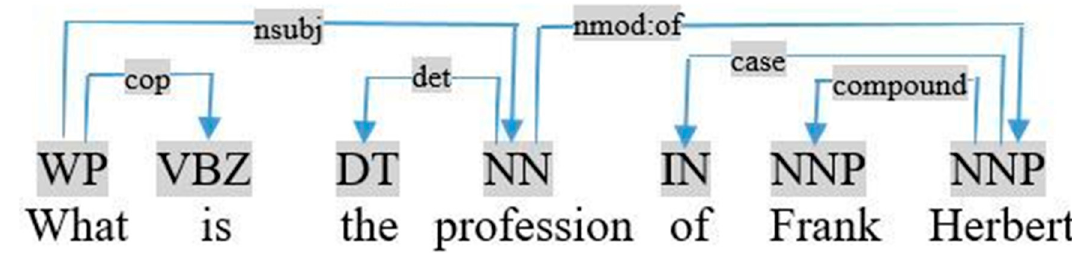
Figure 6. Graph dependency of the query «what is the profession of Frank Herbert».